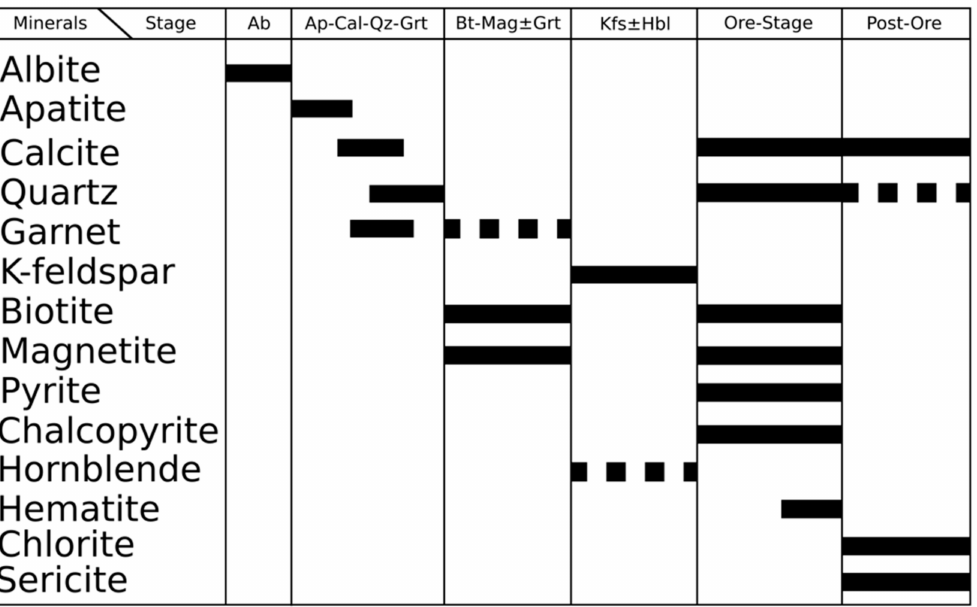
Figure 6. Paragenesis of the Inter-lens. Early albitization is followed by the apatite-calcite-quartz-garnet assemblage, biotite-magnetite ± garnet alteration, K-feldspar ± hornblende alteration, Ore-Stage Cu-mineralization, Post-Ore calcite ± quartz veining, and chlorite/sericite